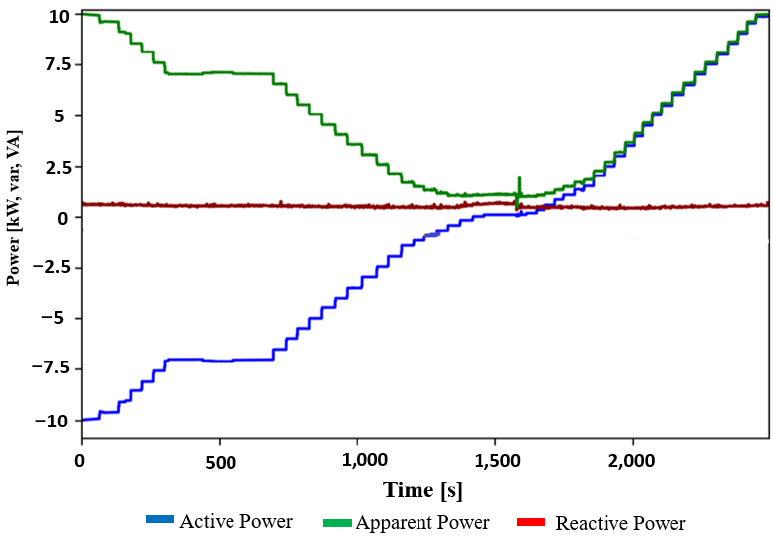
Figure 18. Active, reactive and apparent power.